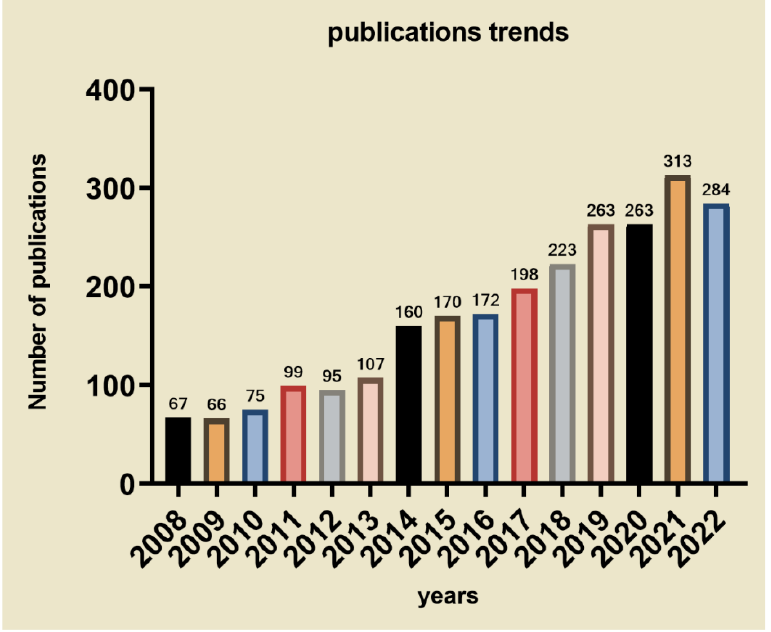
Figure 2. Timeline of papers on various implant-related antimicrobial surface coatings included on web of science in the last decade.